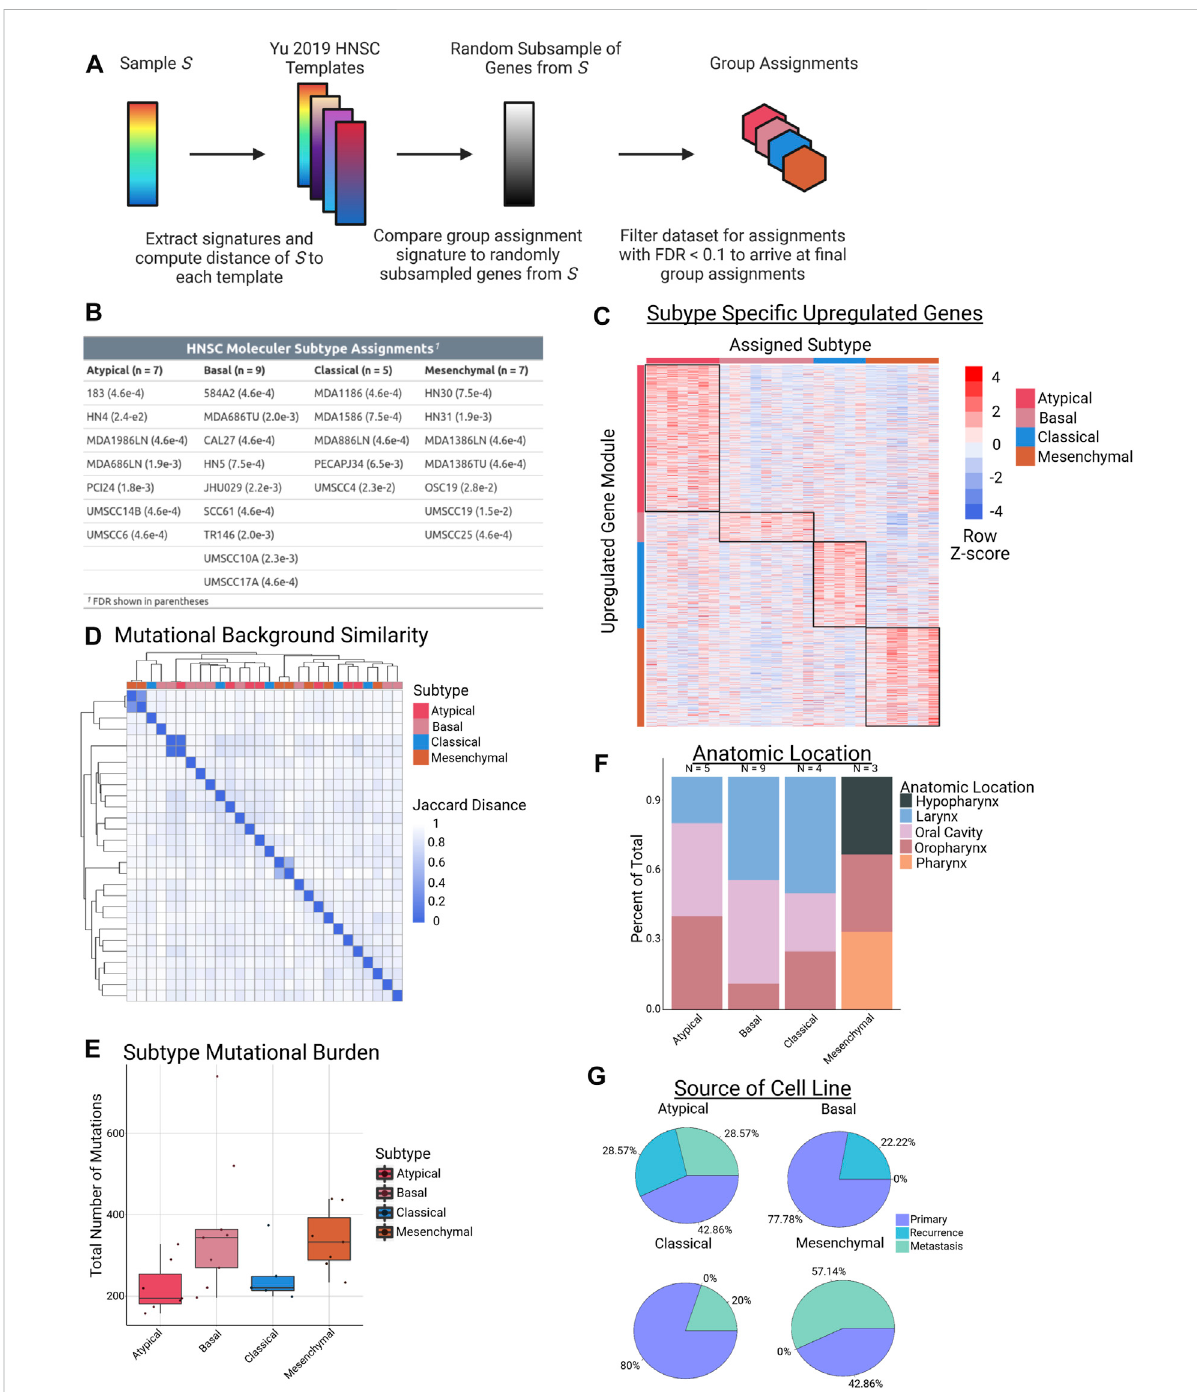
FIGURE 1 Cell line subtype assignmentsand characteristics. (A) Schematic ofwork fl ow used to assign HNSCC cell lines to their respective subtypes using RNA-seq data. (B) Table of subtype assignments for each of the 28 cell lines used in this study. (C) Heatmap of gene expression modules in each molecular subtype, de fi ned as FC > 3 in a one-vs-rest comparison. (D) Hierarchical clustering of the 28 cell lines based on Jaccard distance metrics obtained from binarized mutation counts from WES data. (E) Boxplots demonstrating total number of mutations in each sample, grouped by molecular subtype ( p = NS for each comparison). (F) Stacked barplot showing distribution of cell line anatomic location for each molecular subtype. (G) Pie chart showing percentage of samples in each molecular subtype that came from primary, recurrent, or metastatic